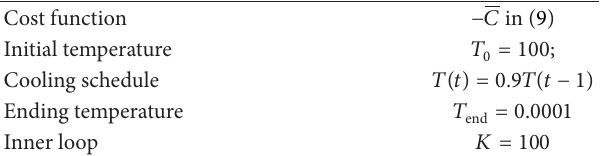
Table 2: Parameters for SA